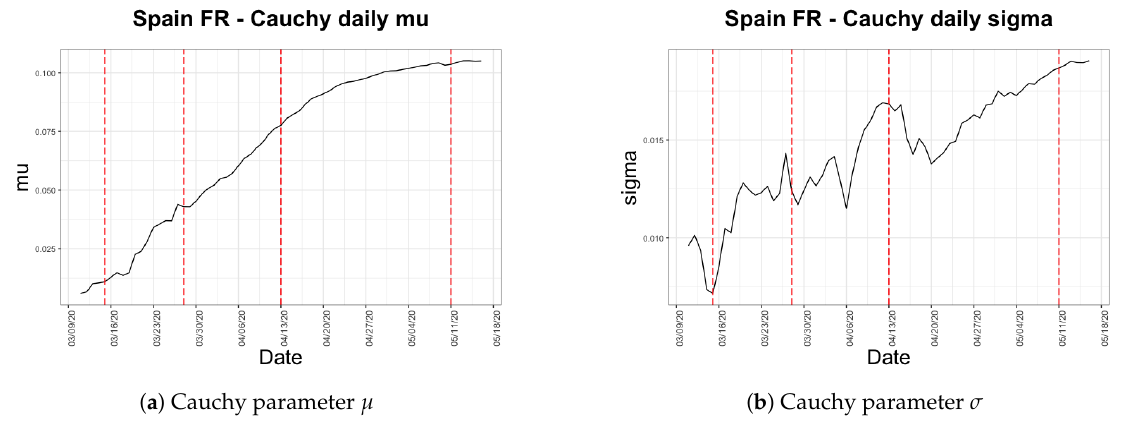
Figure 14. Time series for Spain fatality ratio Cauchy